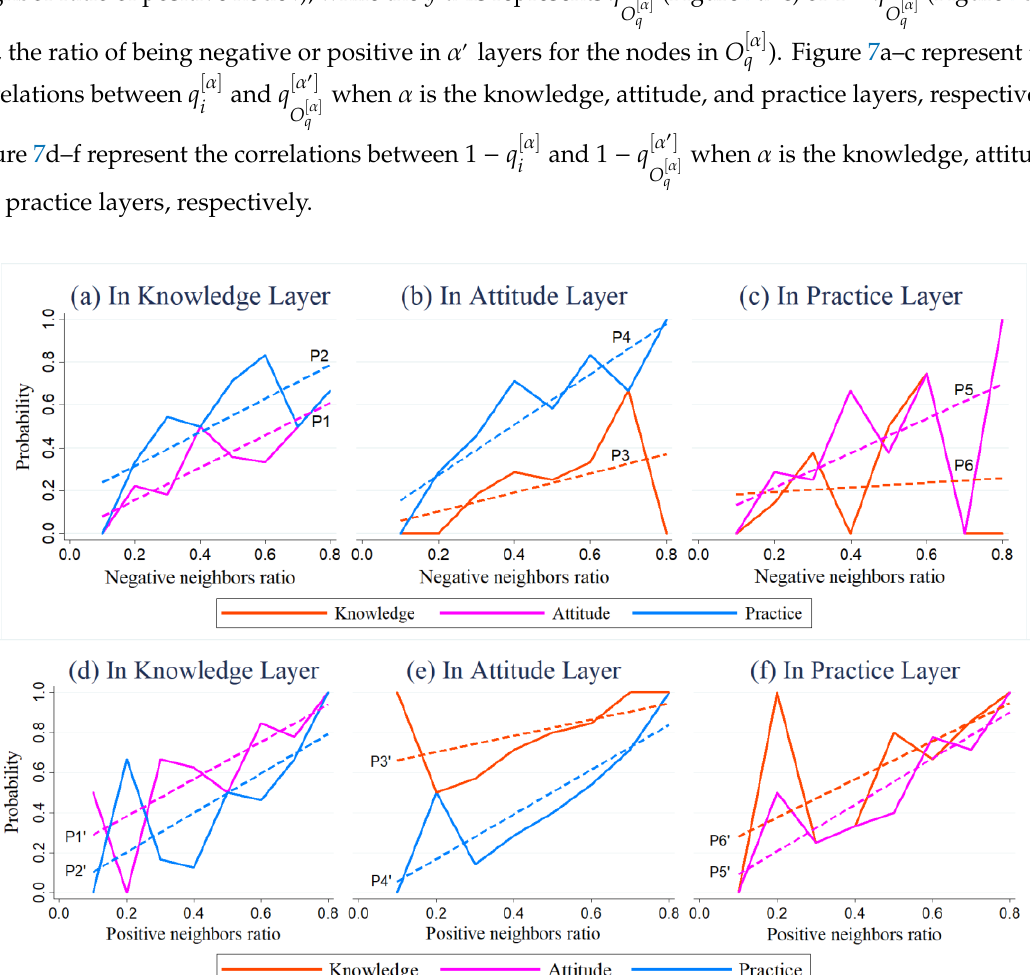
[ α (cid:48) ] [ α (cid:48) ] and 1 − q , O [ α ] q O [ α ] q